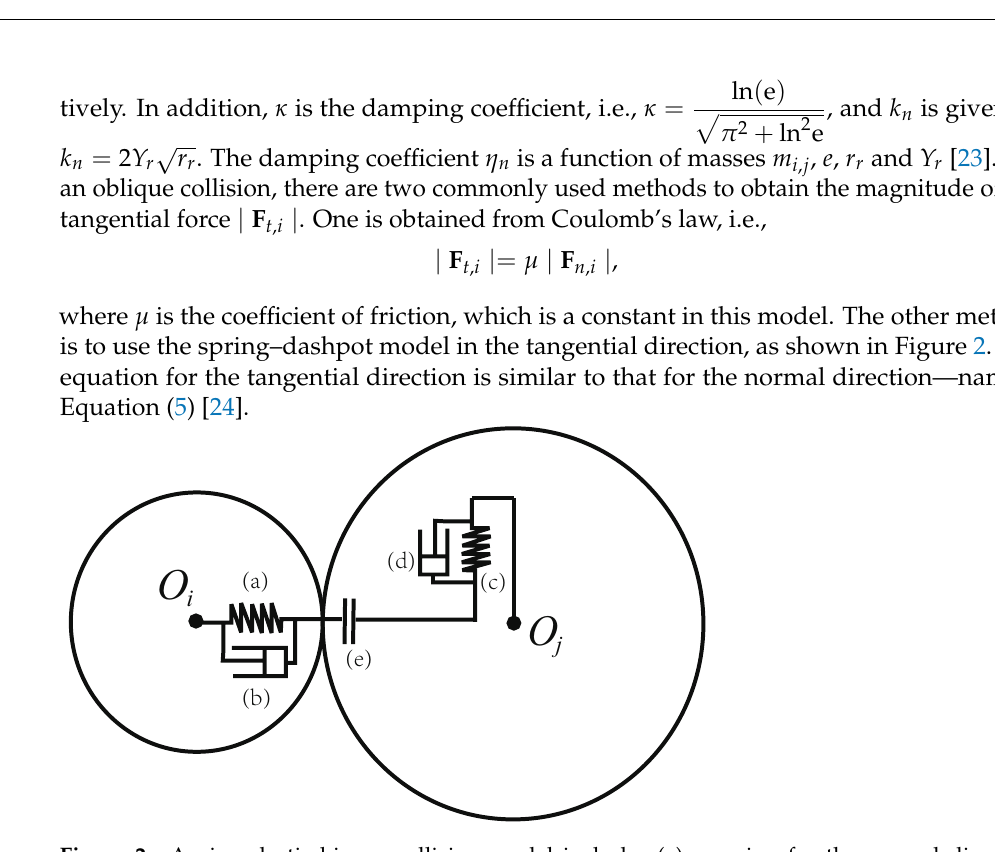
Figure 2. A viscoelastic binary collision model includes ( a ) a spring for the normal direction; ( b ) a dashpot for the normal direction; ( c ) a spring for the tangential direction; ( d ) a dashpot for the tangential direction; and ( e ) a contact judgment